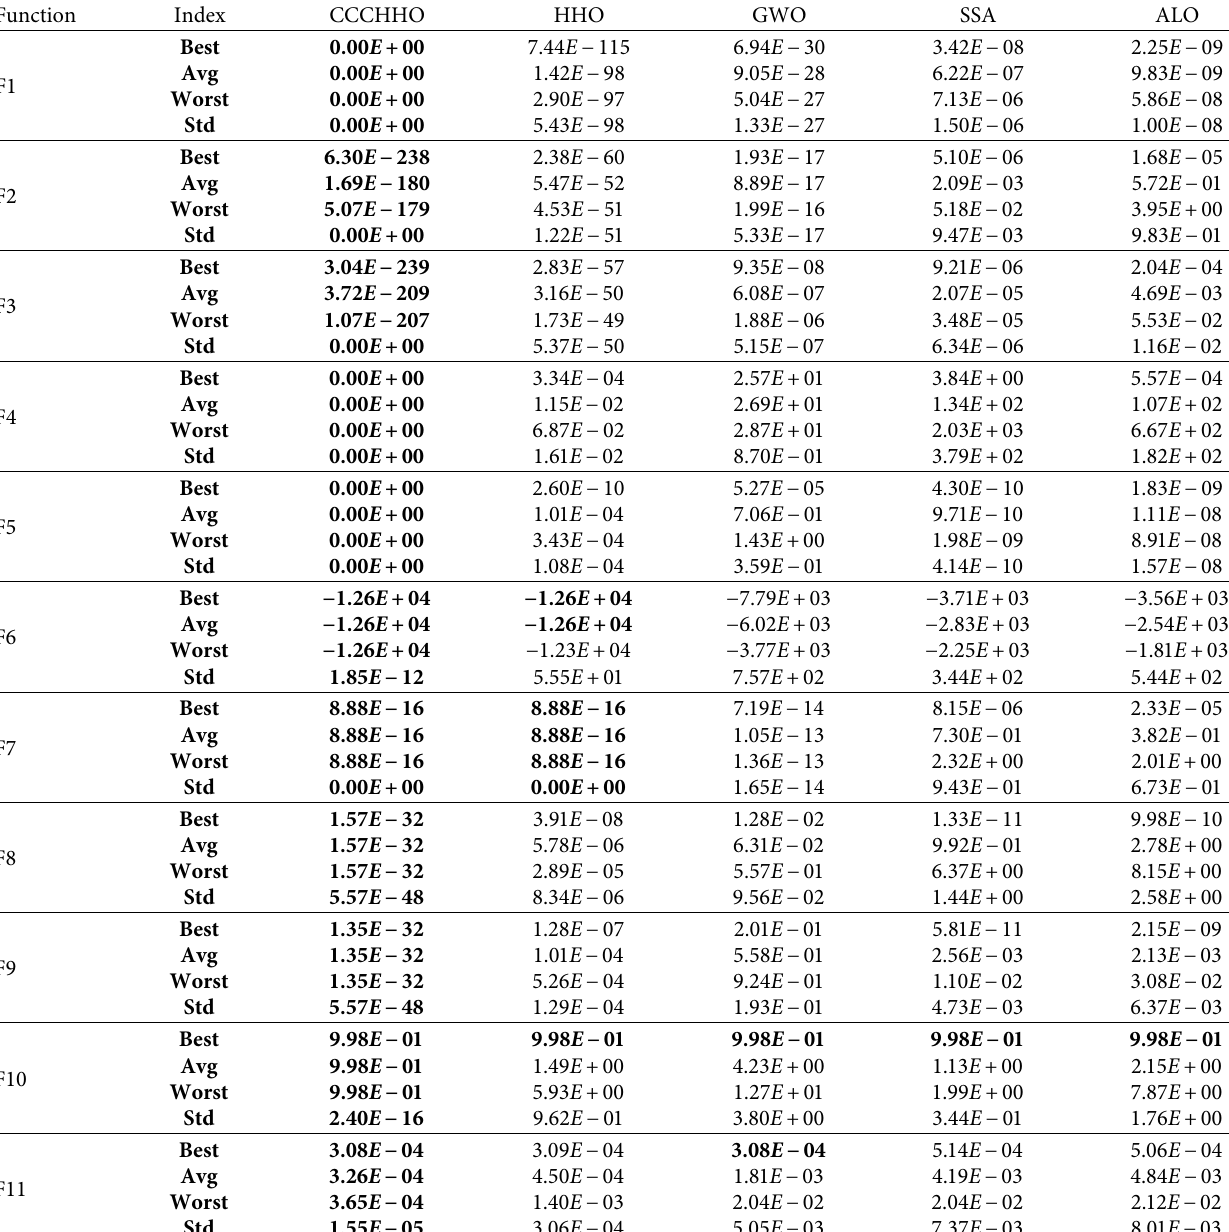
Table 2: The result of the comparison of CCCHHO with HHO, GWO, SSA, and ALO.